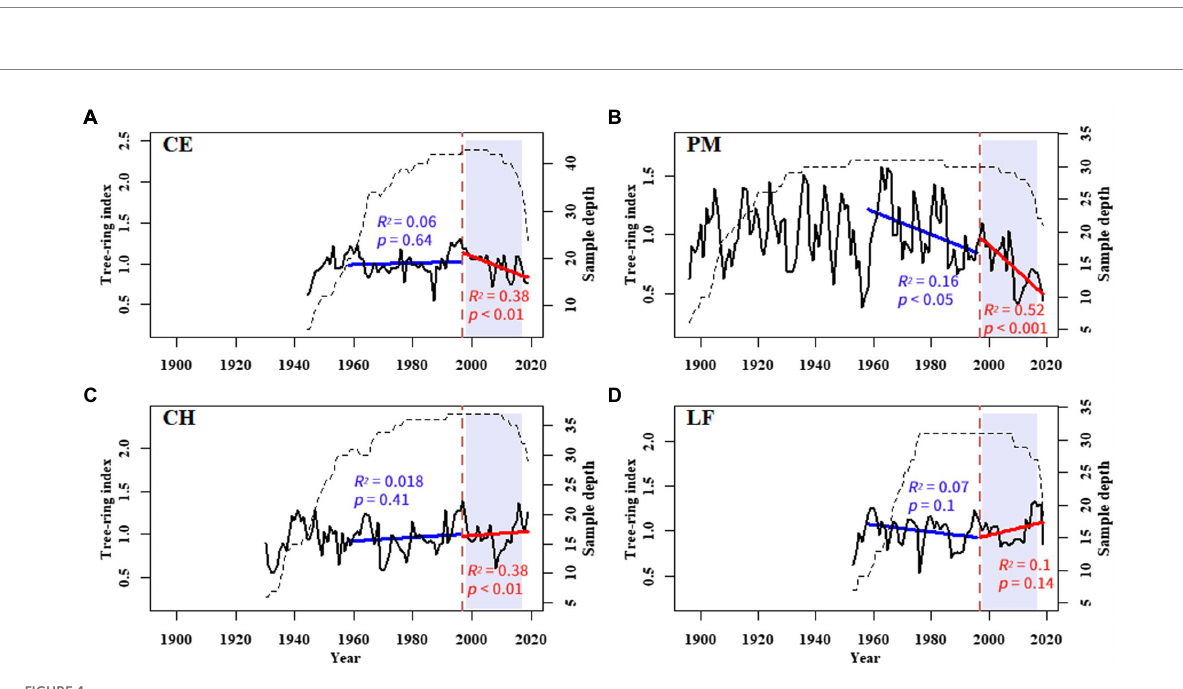
FIGURE 4 Tree-ring width standard chronologies of (A) C. eyrei , (B) P. massoniana , (C) C. henryi , and (D) L. formosana at the northern Luoxiao Mountain. The interannual growth trends from 1958–1996 (blue), and 1997–2019 (red) are fitted by a linear regression equation. The R -squared and value of p of each model are listed in the